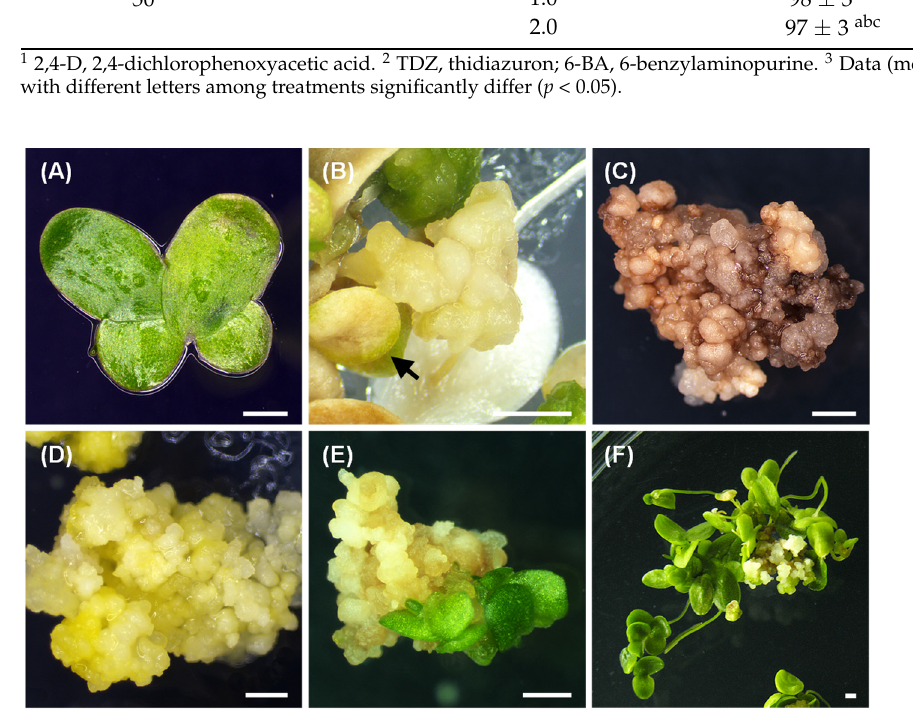
e Figure 2. The effects of 2,4-D and TDZ on callus proliferation. Calli were cultured on the MS me- dium containing 3% sucrose and different plant growth regulators. Data (mean ± SD) with differ- ent letters among treatments significantly differ ( p < 0.05). 2,4-D (μM) 4.5 9.00.5 2.0 R e l a t i ve g r o w t h r a t ( g g - 1 d - 1 ) TDZ (μM) 0.0